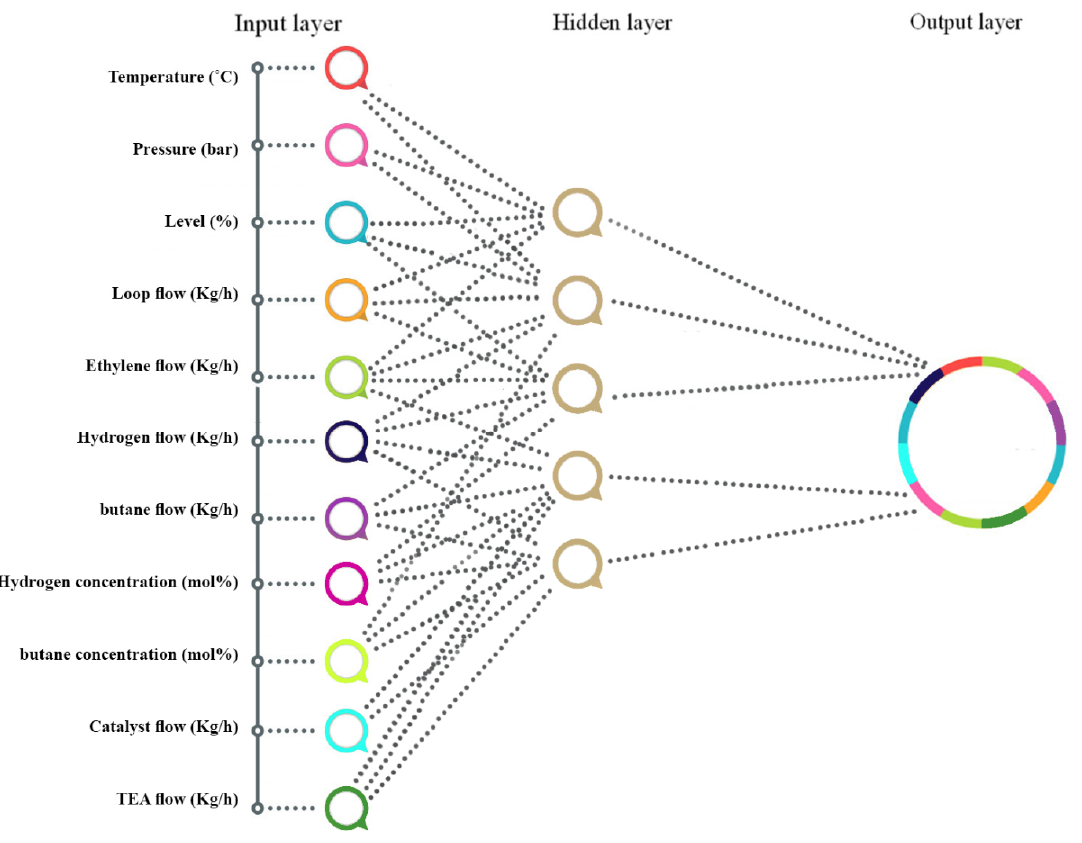
Figure 2. Schematic representation of the used model for neural networks [30].